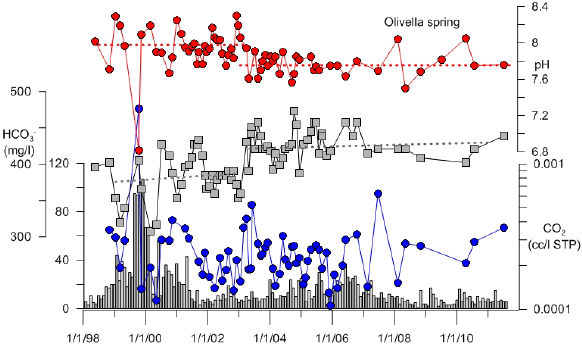
Figure 8. From top to bottom: time trends of the pH, HCO 3− con- tent, and dissolved CO content at Olivella spring. The histogram 2 shows the monthly number of seismic events.